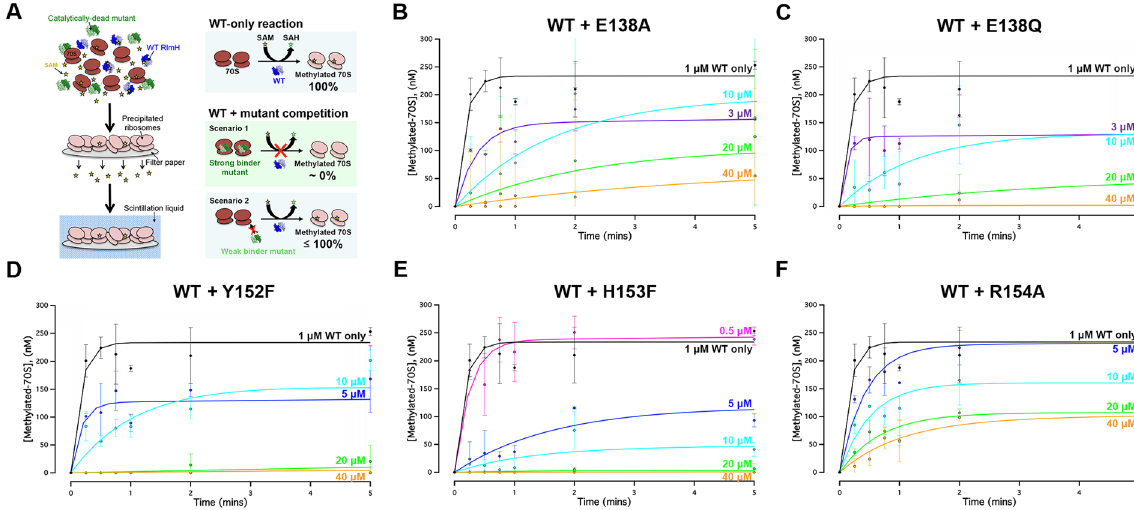
Figure 4. Competition analyses of RlmH mutants. ( A ) Scheme for the in vitro competitive methylation assay. ( B–F ) Time progress curves for methylation of Δ rlmH -70S ribosomes by wild-type RlmH (1 µ M) in competition with E138A, E138Q, Y152F, H153F and R154A mutants at different concentrations. The same curve for methylation by wild-type RlmH is shown (black) in all panels for reference. Error bars show error of fit for two independent